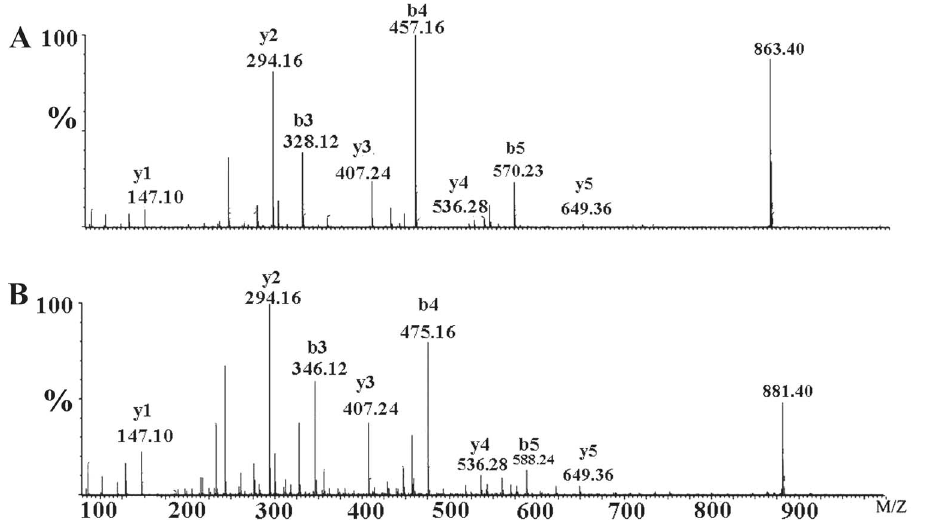
Figure 3. MS/MS spectrum for sequence determination of the first fragment of mHWTX-IV (A) and of HWTX-IV (B) after digestion with trypsin. The sequence was derived from the series of b-ions and y-ions.